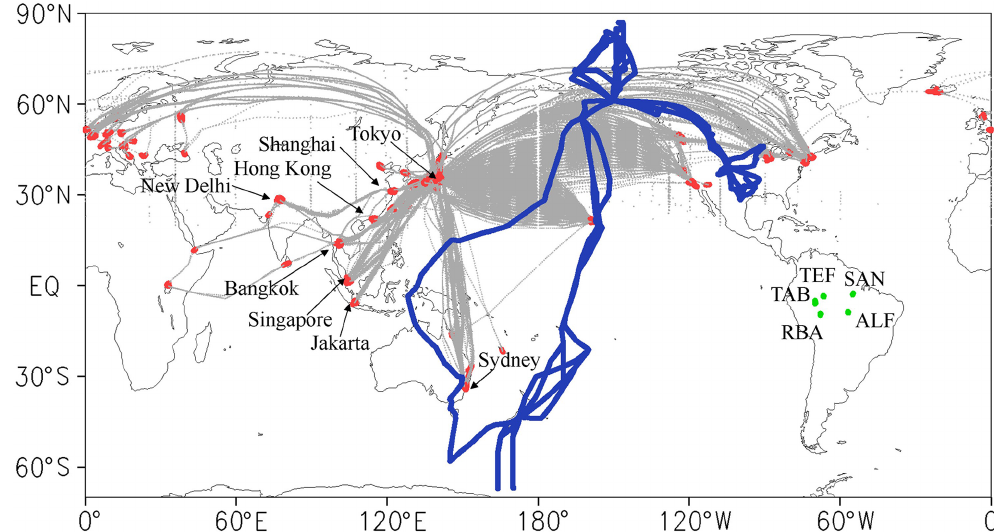
Figure 2. Locations of aircraft observations (red and gray, observations of the CONTRAIL project; red marks show observations below 6km, dark blue observations of the HIPPO project, and green data of the CARBAM